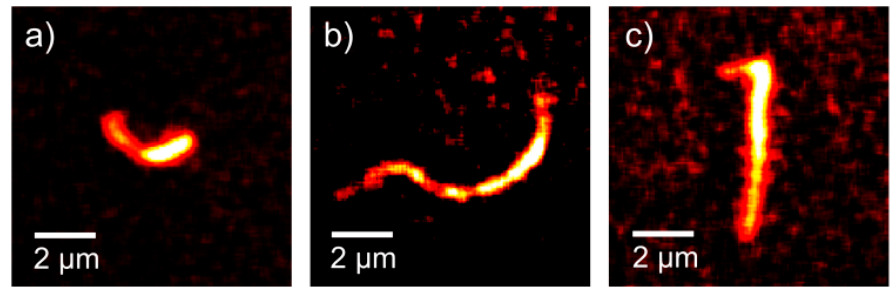
Figure 3. ( a – c ) Typical shapes of microgel chains observed in widefield fluorescence microscopy measurements. The three chains exhibit a C-shape, S-shape and L-shape, respectively. The following contour lengths L were obtained by Easyworm [36]: ( a ) L = 3.8 μ m; ( b ) L = 11.4 μ m; and ( c ) L = 7.6 μ m. The images were filtered as described in the Supplementary Materials, where the corresponding movies can also be found. The corresponding Movies 1–3 can be found in the Supplementary Materials.